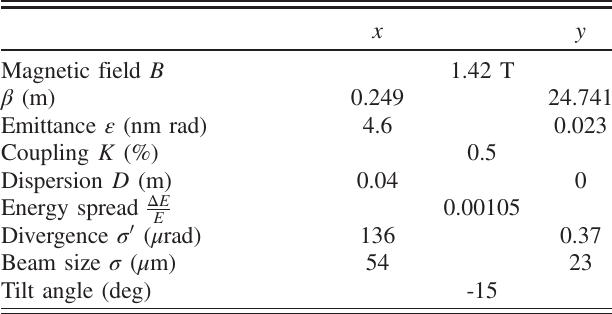
point of the diagnostic beamline Xanadu.